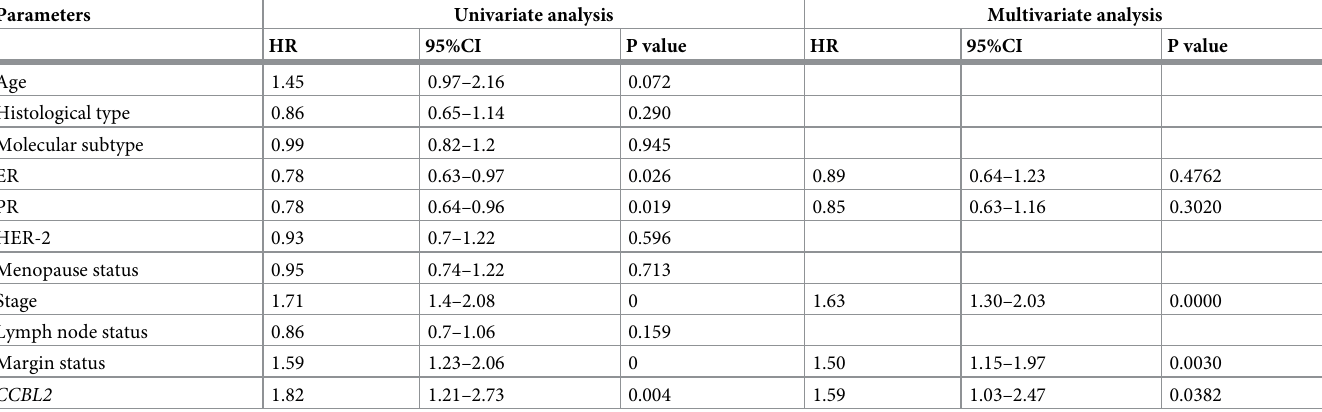
Table 4. Univariate and multivariate analyses of relapse free survival in breast cancer patients.